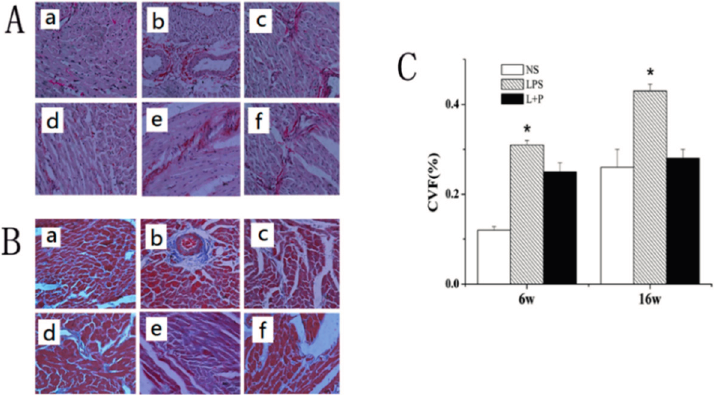
Figure 2. Histopathological changes in the mouse myocardium. ( A ) Sirius red staining (400×): ( a ) six-week-old NS-treated rat; ( b ) six-week-old LPS-treated rat; ( c ) six-week-old LPS + PTDC-treated rat; ( d ) 16-week-old NS-treated rat; ( e ) 16-week-old LPS-treated rat; ( f ) 16-week-old LPS + PTDC-treated rat; ( B ) Masson staining (400×): ( a ) six-week-old NS-treated rat; ( b ) six-week-old LPS-treated rat; ( c ) six-week-old LPS + PTDC-treated rat; ( d ) 16-week-old NS-treated rat; ( e ) 16-week-old LPS-treated rat; ( f ) 16-week-old LPS + PTDC-treated rat. No collagen accumulation was observed in the control group ( A . a , A . d , B . a , B . d ); many collagen fibers were observed in the LPS group ( A . b , A . e , B . b , B . e ); and few collagen fibers were observed in the LPS + PDTC group ( A . c , A . f , B . c , B . f ); ( C ) The collagen volume fraction (CVF), which was calculated by quantitative morphometry using an automated image analysis system. The data are presented as the means ± SD; n = 8. * p < 0.05 compared with the NS group.